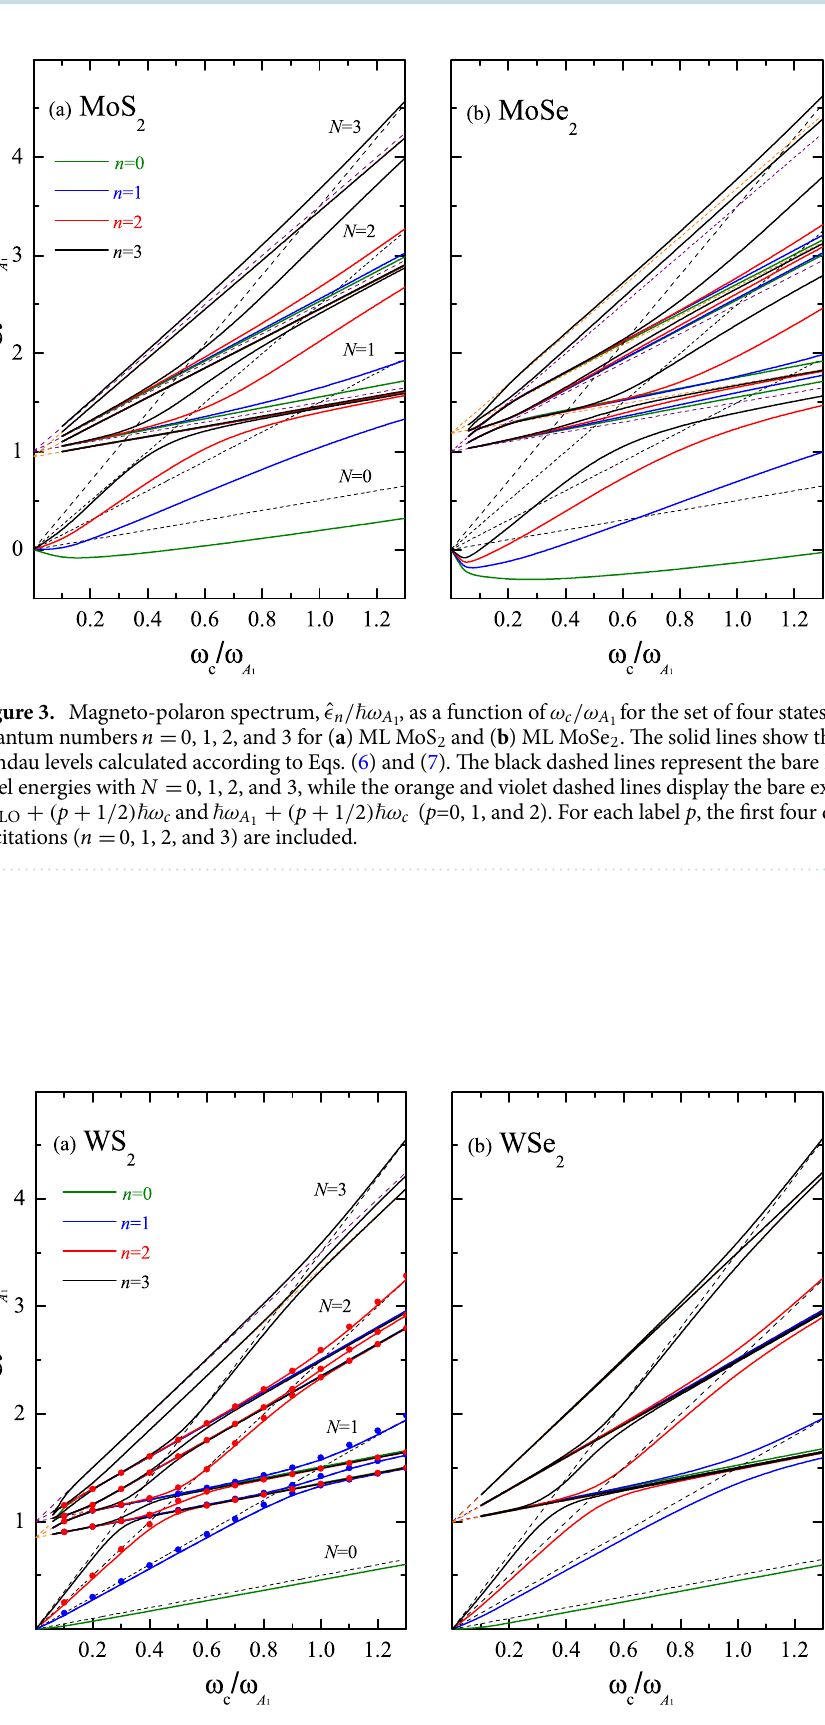
Figure 4. The same as Fig. 3 for ( a ) WS 2 and ( b ) WSe 2 . Dots represent the two-level approximation of Eq.